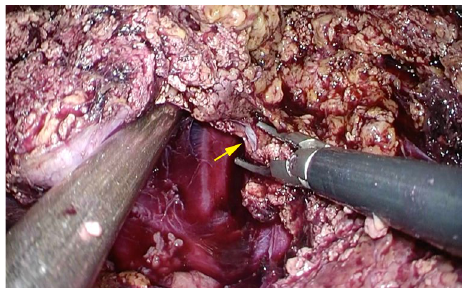
Figure 4. Dorsal compression, compressing the liver parenchyma from the dorsal side, enables con- trol of bleeding from a branch of the hepatic vein. The yellow arrow is the bleeding point from the hepatic vein.